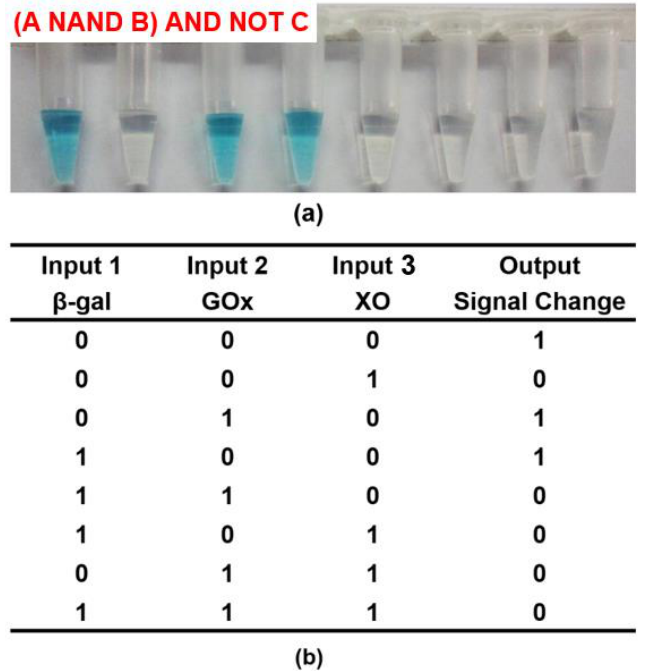
Figure 7. ( a ) Output result, and ( b ) truth table of (A NAND B) AND NOT C logic gates. ([TMB] = 120 μM, [CeO 2 NPs] = 4 μg/mL, [β-gal] = 10 units/mL, [GOx] = 1 unit/mL, [lactose] = 25 mM, [glucose] = 120 µ M, [CeO 2 NPs] = 4 µ g/mL, [ β -gal] = 10 units/mL, [GOx] = 1 unit/mL, [lactose] = 25 mM, = 5mM, [xanthine] = 100 μM, [XO] = 0.04 unit/mL, [citrate buffer] = 40 mM, pH 6.0). [glucose] = 5mM, [xanthine] = 100 µ M, [XO] = 0.04 unit/mL, [citrate buffer] = 40 mM, pH